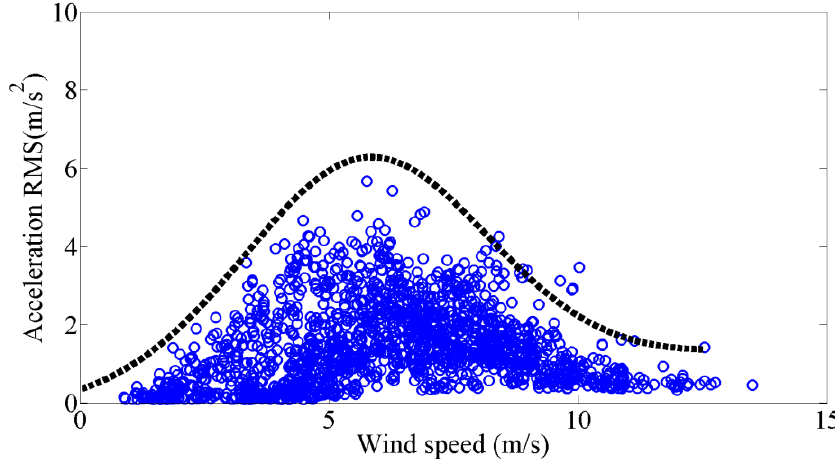
Figure 10. Validation of the presented relationship between the vibration amplitude and the mean wind speed.